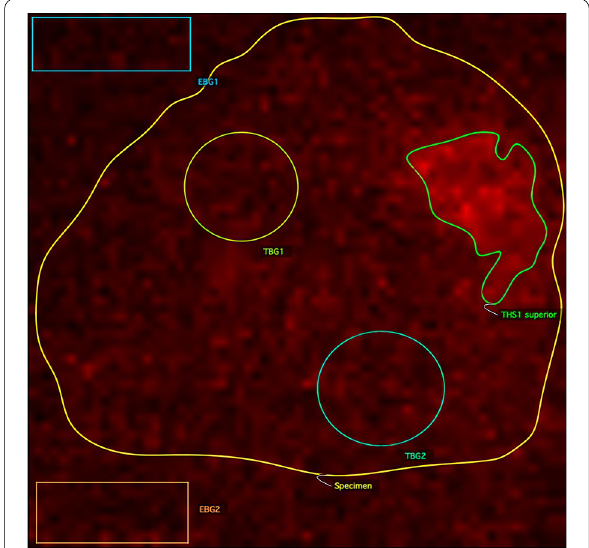
Fig. 3 A WLE excision specimen (outlined in yellow) analysed in OsiriX Lite version 11. ROIs are drawn to quantify the signal intensity of the empty background (EBG), tissue background (TBG) and tumour hotspot (THS). The area of increased signal intensity at the superior margin (THS1 superior) contained invasive carcinoma